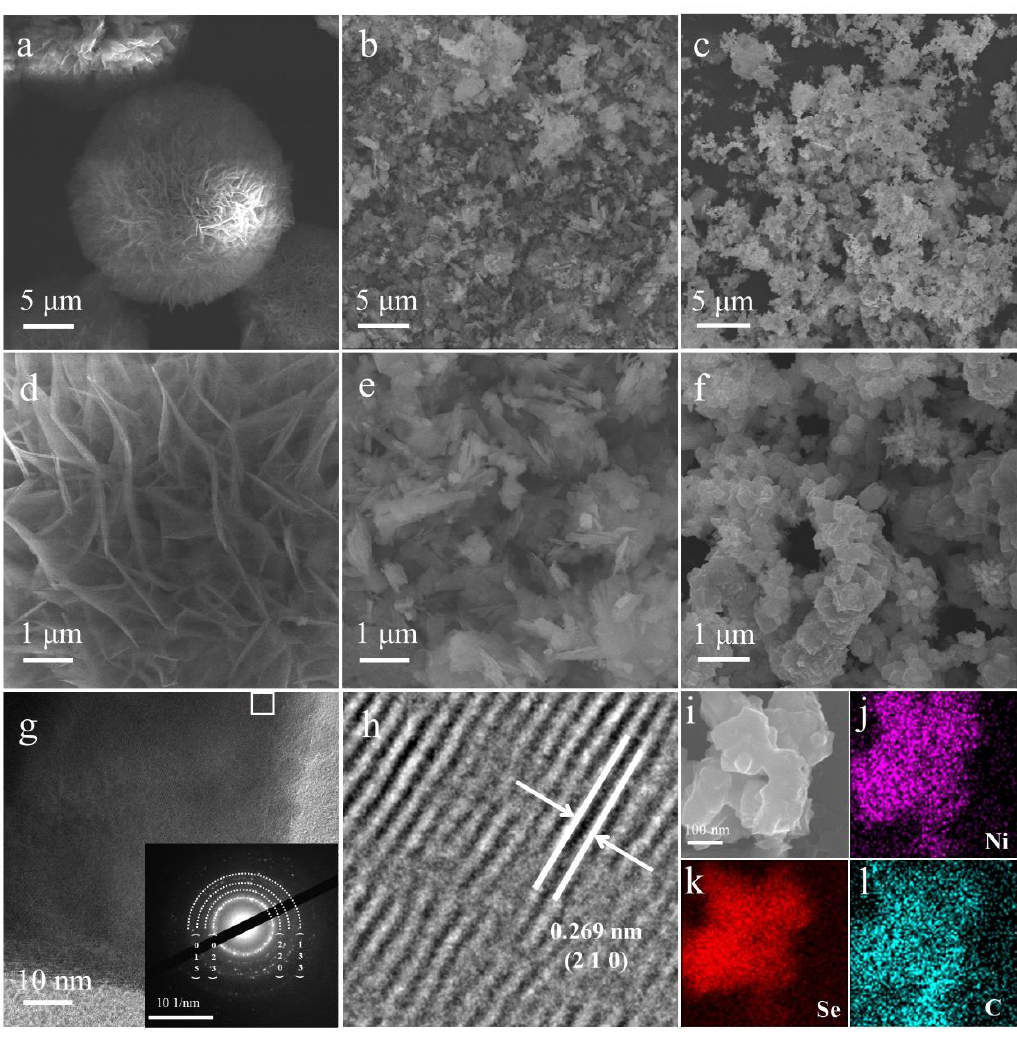
Figure 1. SEM images of the ( a ) Ni-MOFs, ( b ) NiSe 2 − 0.5, and ( c ) NiSe 2 − 1 samples at low magnification. The SEM images of the corresponding area of ( d ) Ni-MOFs, ( e ) NiSe 2 − 0.5, and ( f ) NiSe 2 − 1 samples at high magnification. ( g ) TEM image of NiSe 2 − 1 sample and corresponding SAED pattern (inset). ( h ) HRTEM image of NiSe 2 − 1 sample. ( i – l ) EDS mapping.